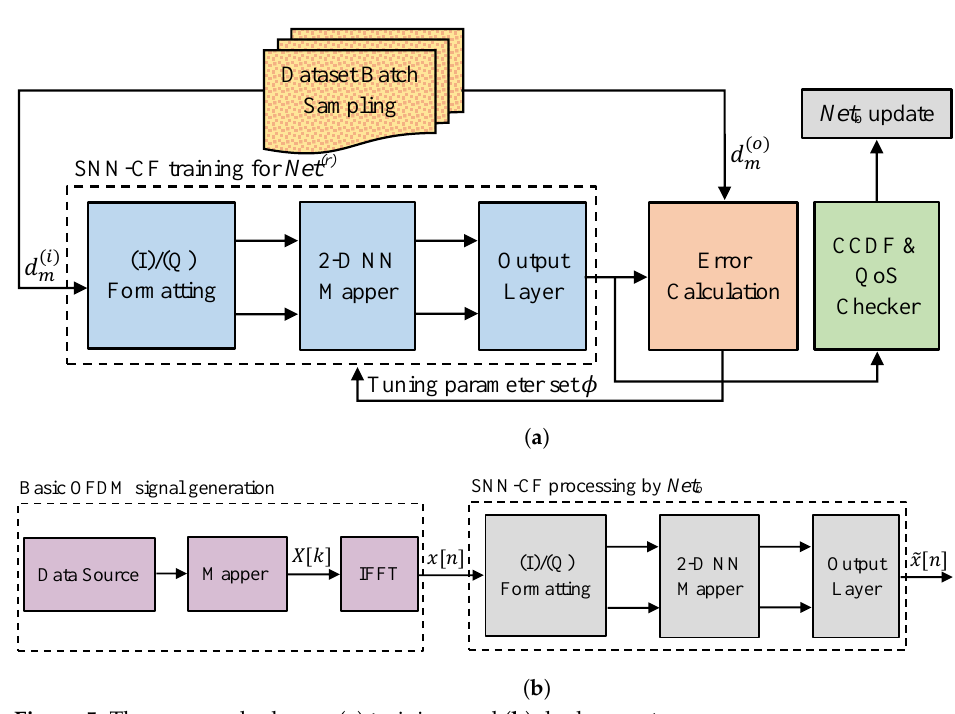
Figure 5. The proposed scheme: ( a ) training; and ( b )